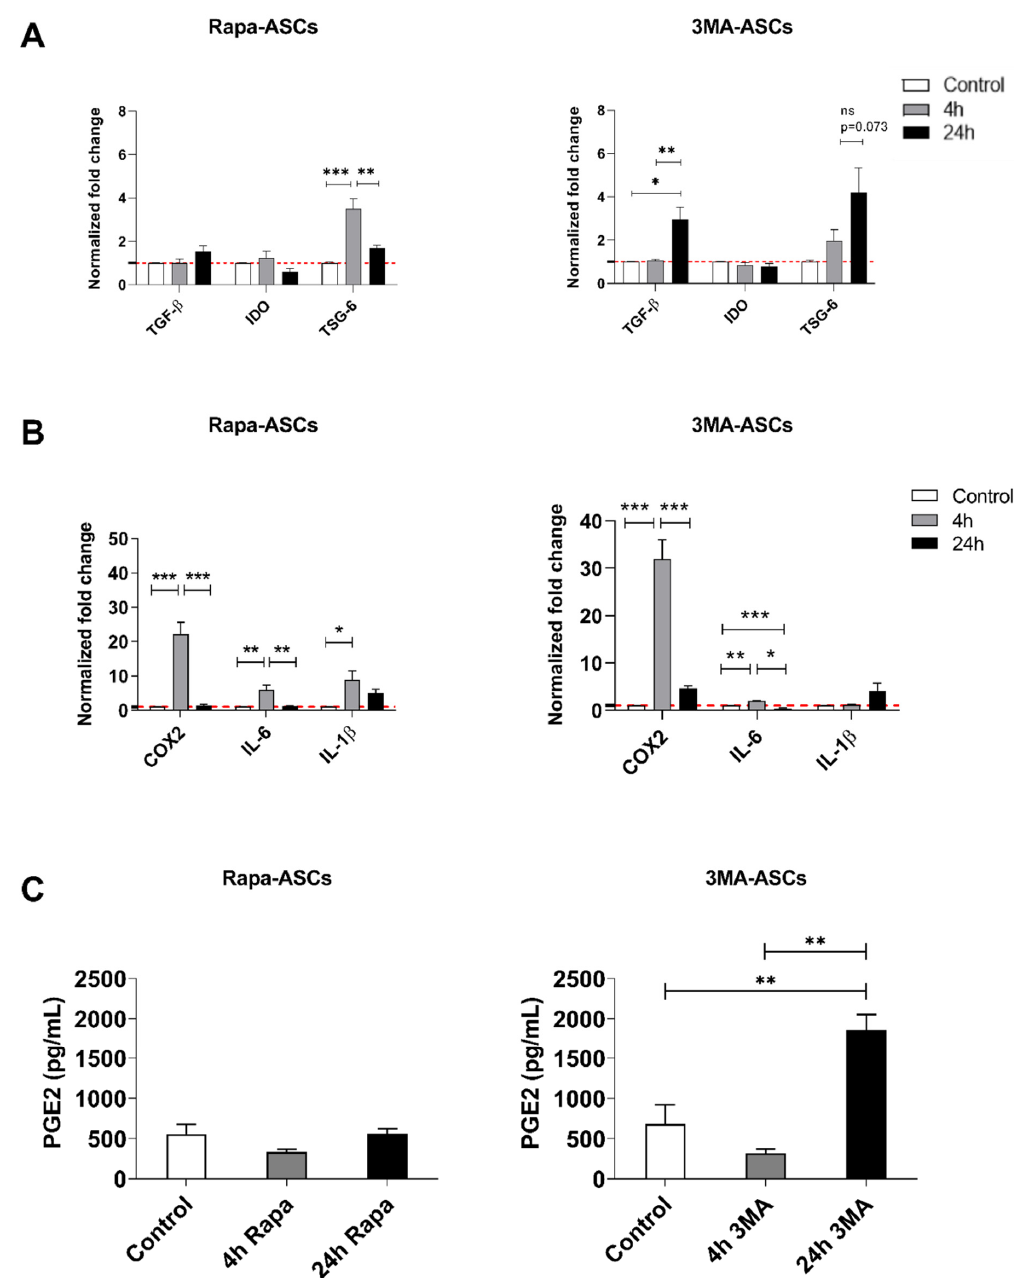
Figure 2. Autophagy preconditioning in hASCs alters expression of both anti-inflammatory and pro-inflammatory mediators. Rapa-ASCs (left) and 3MA-ASCs (right) were treated for 4 or 24 h, then relative expression levels of anti-inflammatory ( A ) and pro-inflammatory ( B ) genes were measured via RT-qPCR by using the ΔΔ Ct method. Data are presented as mean relative fold-change ± SEM of 4 independent experiments. ( C ) Secreted PGE2 levels were measured via ELISA in 24 h CM from control and autophagy preconditioned hASCs. Data are presented as means ± SEM of 3 independent experiments. Statistical analysis was performed by using one-way analysis of variance (ANOVA), and differences between the means are indicated with * p < 0.05, ** p < 0.01, *** p < 0.001. Abbreviations: TGF- β , transforming growth factor-beta; IDO , indoleamine 2,3-dioxygenase; TSG-6 , TNF Alpha Induced Protein 6, COX2 , cyclooxygenase 2; IL-6 , interleukin-6; IL-1 β , interleukin-1 beta; PGE2, prostaglandin